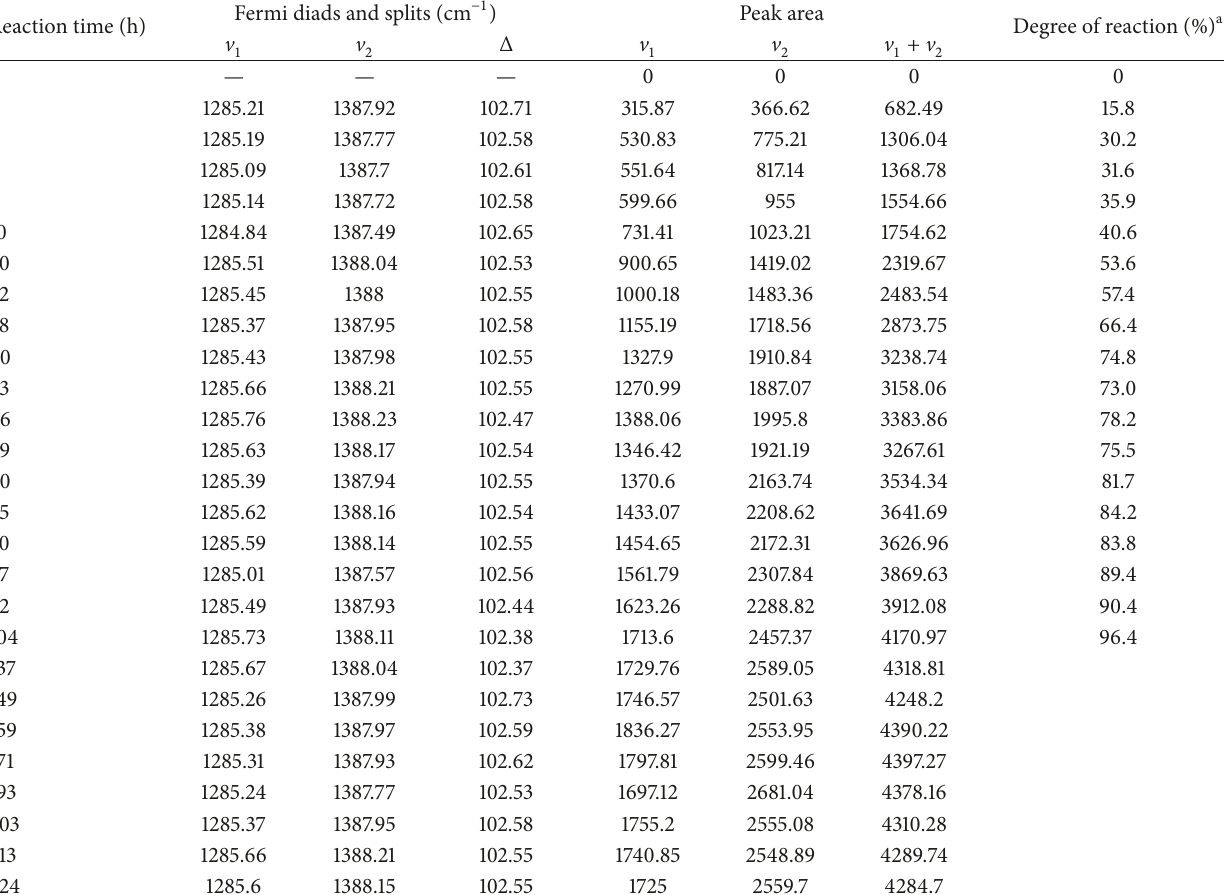
Table 1: Fermi diad bands, splits, and peak areas of CO 2 generated in the FSCC containing dolomite and water at 200 ∘ C, and the calculated degree of